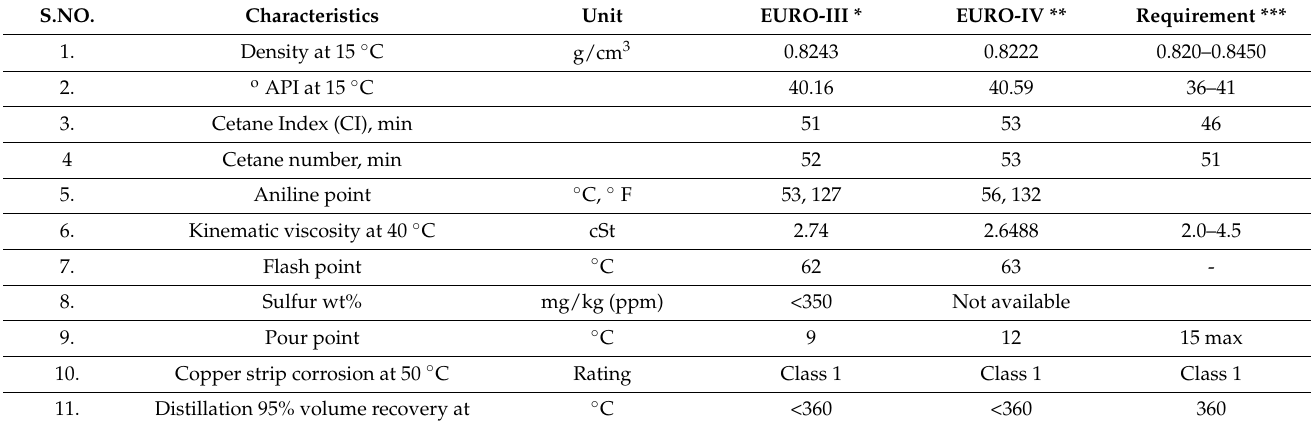
Table 4. Physicochemical characterization of EURO-III and EURO-IV high-speed